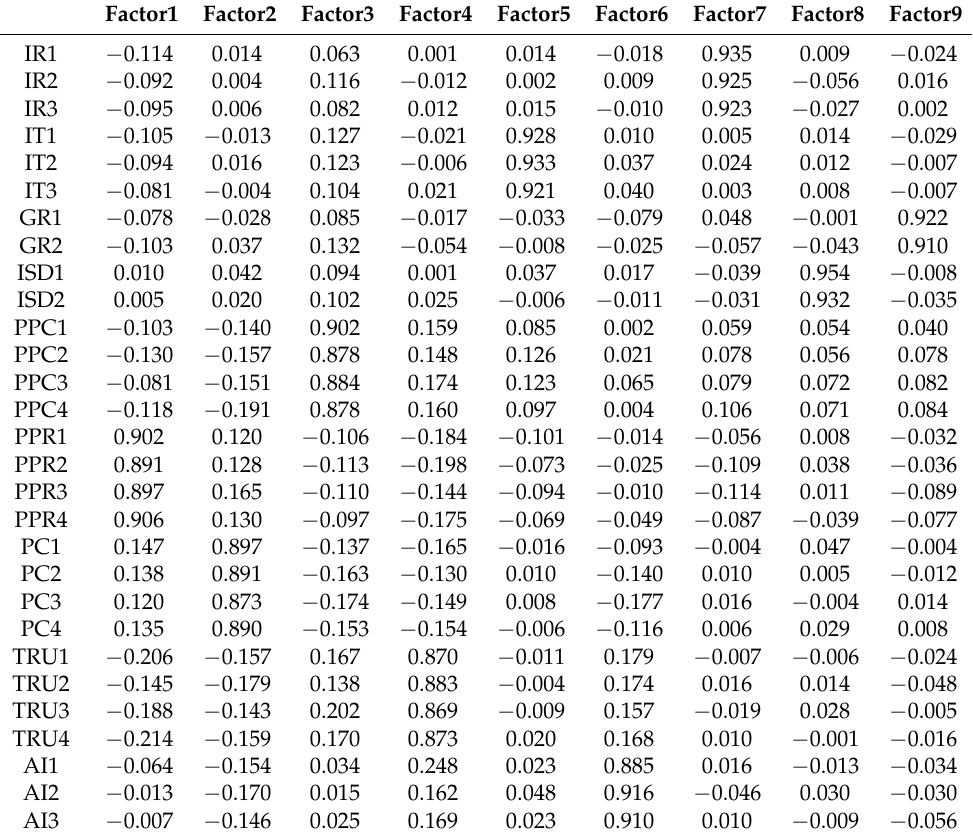
Table 4. Construct cross-loadings.